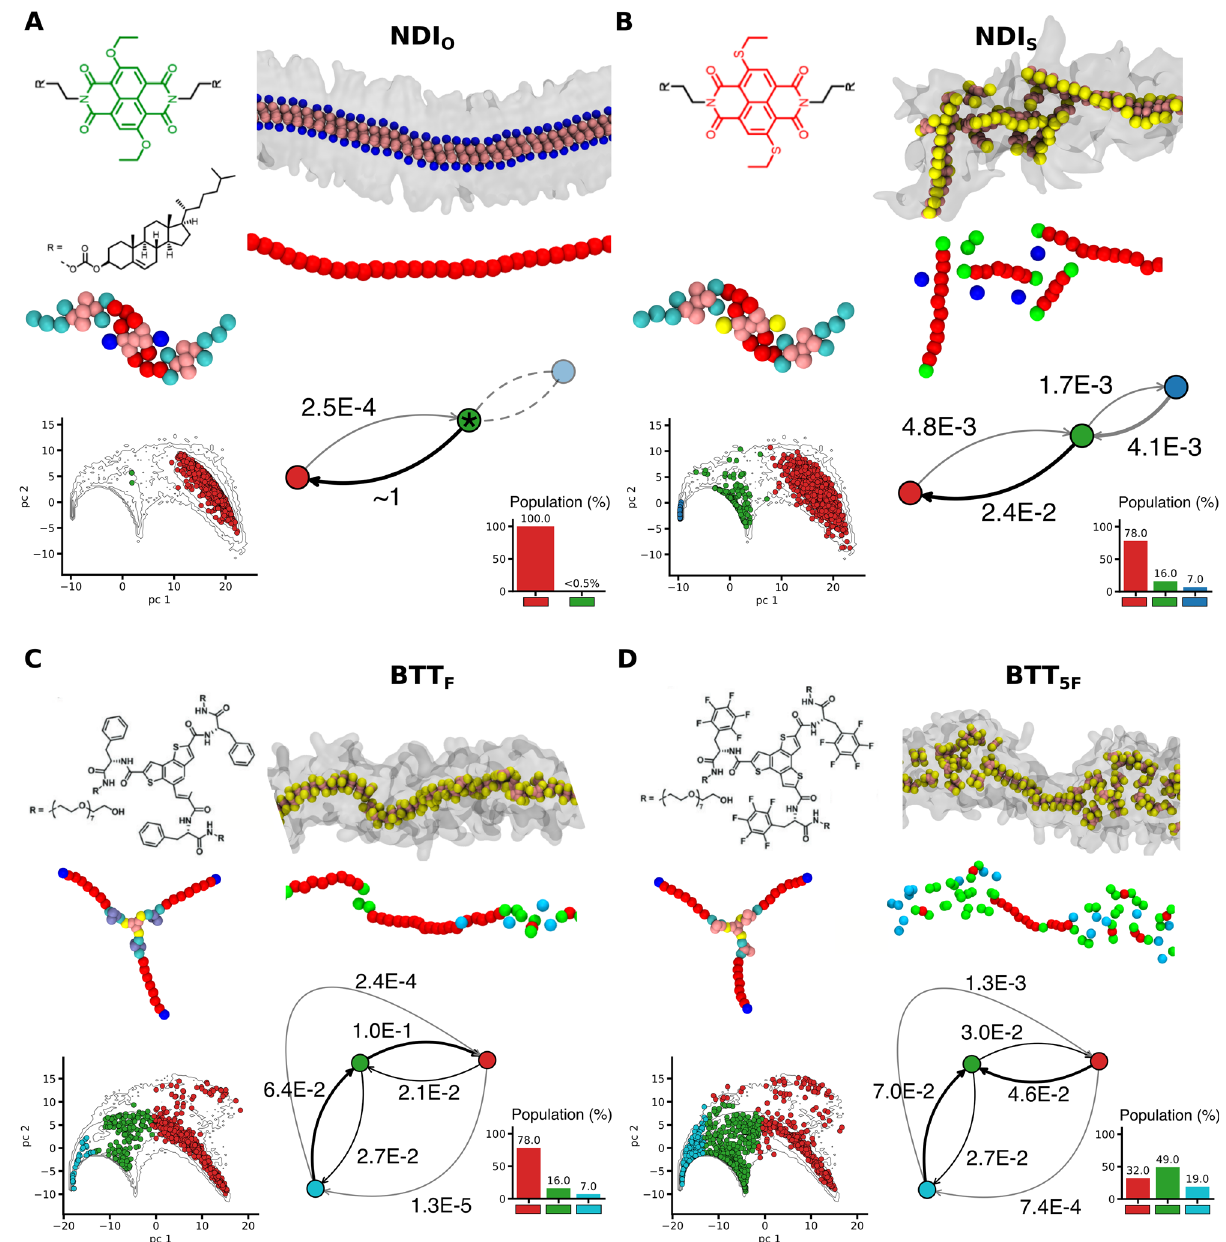
Fig. 2 Comparing variants of supramolecular polymers. A – D SOAP and PAMM analysis on NDI and BTT supramolecular polymer variants: ( A ) NDI O monomer, ( B ) NDI S monomer, ( C ) BTT F monomer, and ( D ) BTT 5 F monomer. Each panel summarizes the results of the analysis for a single system variant, showing (from top-left): chemical structure and CG model of the monomer; equilibrium CG-MD snapshot of the assembly, and view of the same with monomer centers colored according to the identi fi ed molecular motifs; scatter-plot showing the PCA (projected on the fi rst two PCs) of SOAP descriptors, colored according to the motif. Interconversion diagram and population histogram. Asterisks indicate rare fl uctuation states, with residence time ~0 (e.g., green cluster in NDI O backbone (in red), defects (in green) and adsorbed/surface- diffusing monomers (in blue). This distinction in three macro- states is used in the the PCA scatter plots of Fig. 3A to classify the SOAP states sampled by the individual systems, overimposed on the global SOAP distribution (contour plot). These scatter plots can represent characteristic “ fi ngerprints ” of the supramolecular structures, indicating which molecular states are populated in each system. Qualitatively, such fi ngerprints provide an informa- tion of similarity between systems, in terms of structural arrangement and dynamicity of the monomers. However, since Figs. 1, 2, three main structural clusters are identi fi ed by PAMM: PCA scatter plots are the result of a dimensionality reduction,